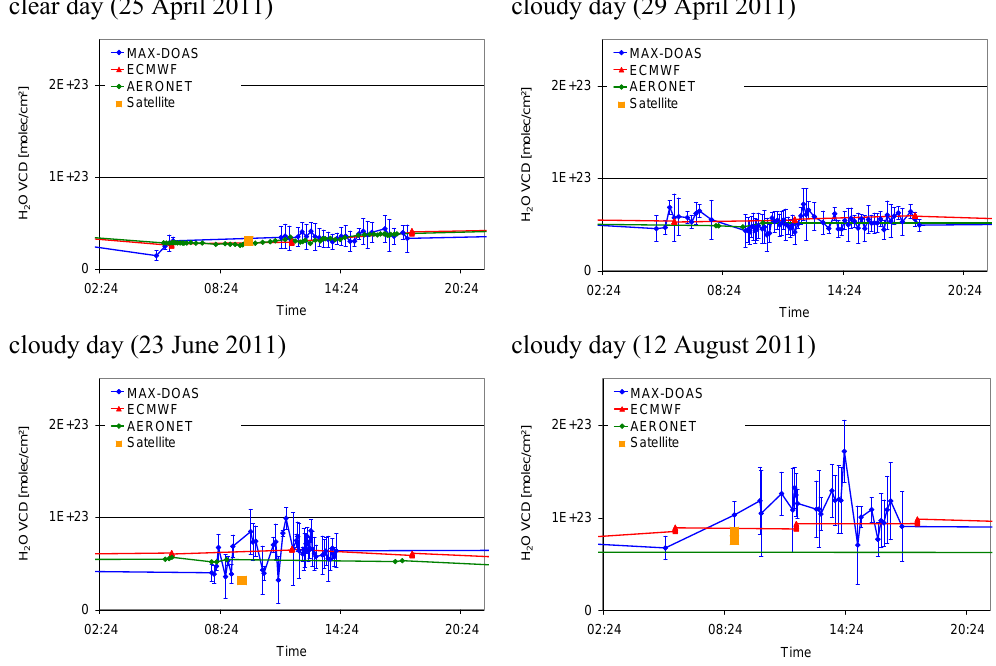
Fig. 11. Diurnal variation of the H 2 O VCD from the different data sets for selected days. The error bars of the MAX-DOAS data are calculated using Eq. (8). On the two cloudy days, in the bottom part of the figure, the scatter of the MAX-DOAS data is rather large indicating a strong cloud effect and/or rapid variation of the cloud properties. The increased scatter is well represented by the enhanced values of the error bars.